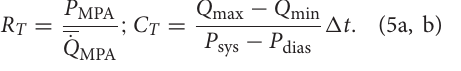
FIGURE 1 | Comparison of (A) end-diastolic diameter and (B) RAC between control and PAH groups. The PAH group has significant larger diameter (median: 32 mm, IQR: 5.25 mm vs. median: 25 mm, IQR: 2 mm; P and lower RAC (median: 0.22, IQR: 0.10 vs. median: 0.42, IQR: 0.04; P 0.004) compared to the control group. =